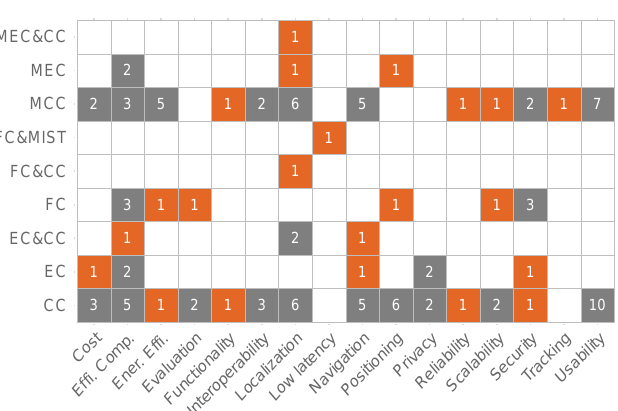
Figure 5. Computing paradigms and studies analysed main